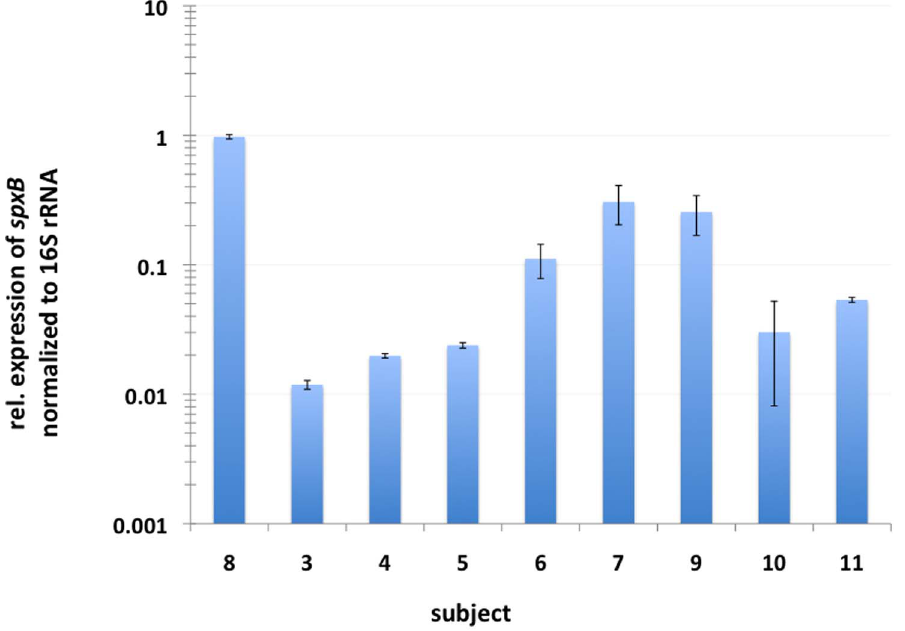
Figure 5. Expression of spxB in freshly isolated human oral plaque samples. One time expression measurements of spxB from 8 different subjects. Expression was normalized to 16S rRNA expression and subject 8 arbitrary set as 1. Error bars represent standard deviations of technical repeats (n=3).